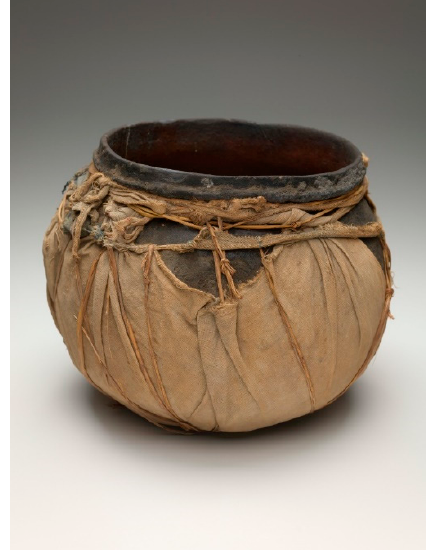
Figure 3. Tesuque Pueblo Jar. Collected by John Louw Nelson (a musical performer and amateur ethnologist) in 1930 during fieldwork sponsored by the Museum of the American Indian. Possibly created between 1870–1900. 17/6153. Used by permission of the Smithsonian Institution, National Museum of the American Indian.